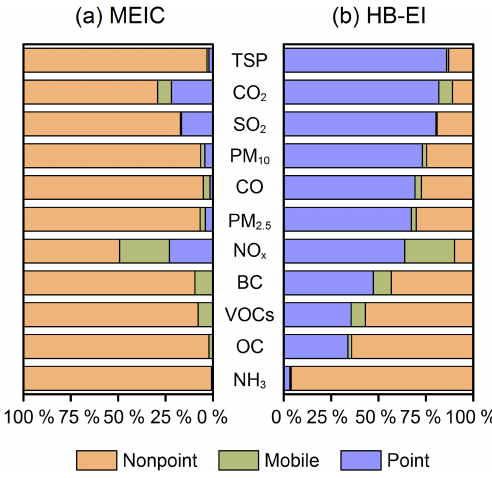
Figure 2. Emission percentages contributed by point, nonpoint, and mobile sources in Hebei Province: (a) the MEIC inventory, (b) the HB-EI